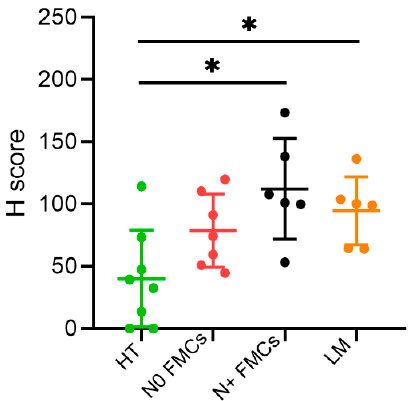
Figure 2. H-score of TFR-1 protein expression. H-score value of 27 samples of feline mammary gland tissue: healthy tissue (HT) ( n = 8, green) (mean 40.07 ± SD 38.95), feline mammary carcinoma without lymph node metastasis (N0 FMCs) ( n = 7, red) (mean 78.72 ± SD 29.41), feline mammary carcinoma with lymph node metastasis (N+ FMCs) ( n = 6, black) (mean 112.28 ± SD 40.51), and lymph node metastasis (LM) ( n = 6, orange) (mean 99.48 ± SD 27.95). The H-score value was significantly higher in N+ FMCs and in LM as compared to HT (* p < 0.05).